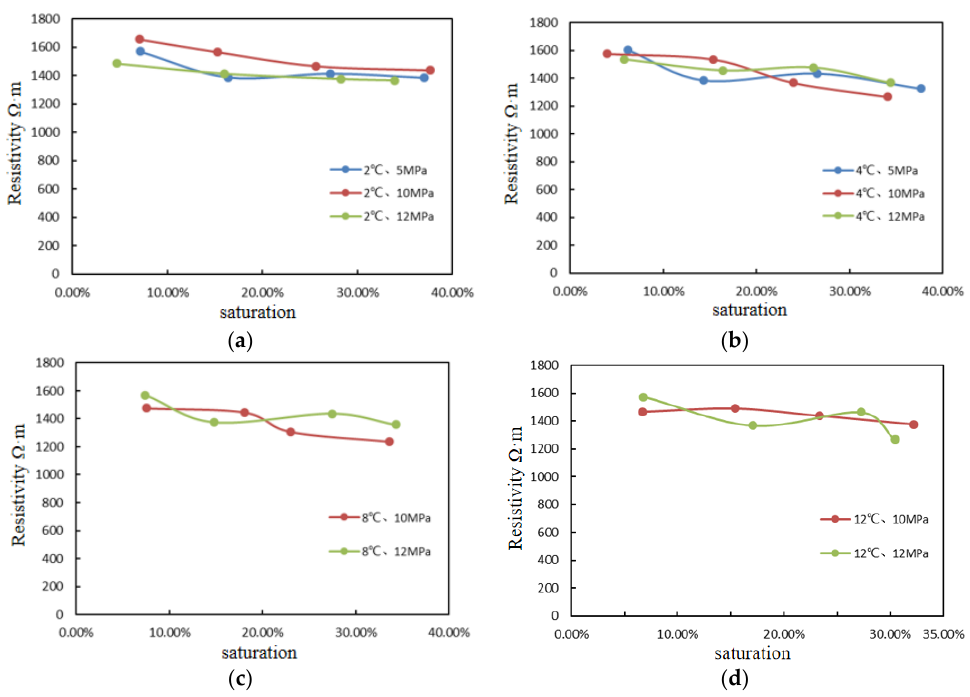
Figure 6. Relationship between resistivity and saturation of hydrates ( a ) The test temperature is 2 °C; ( b ) The test temperature is 4 °C; ( c ) The test temperature is 8 °C; ( d ) The test temperature is 12 °C. As for muddy silt hydrate, the resistivity data of cores with different particle sizes,